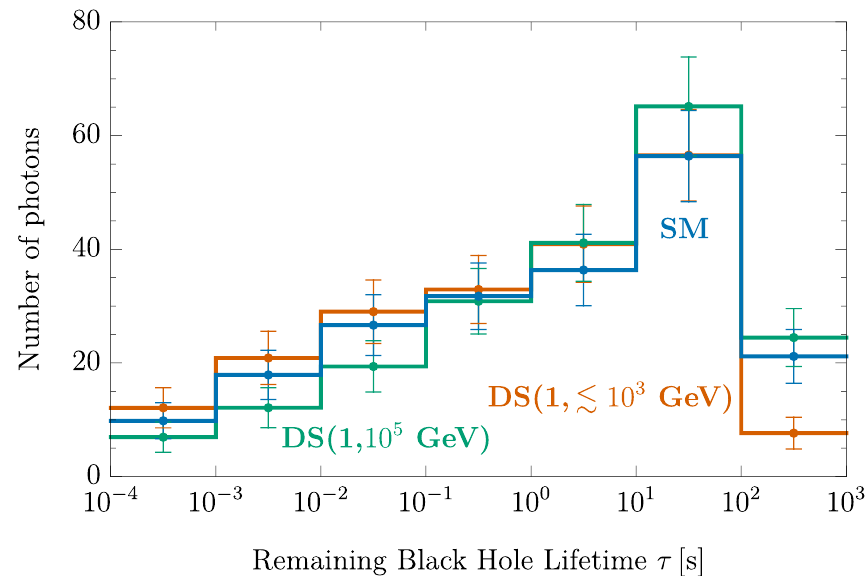
Figure 4: The number of photons observed in each time window normalised to 200 total photons, for the SM and dark sector models at different mass scales. The error bars include statistical and 5% systematic